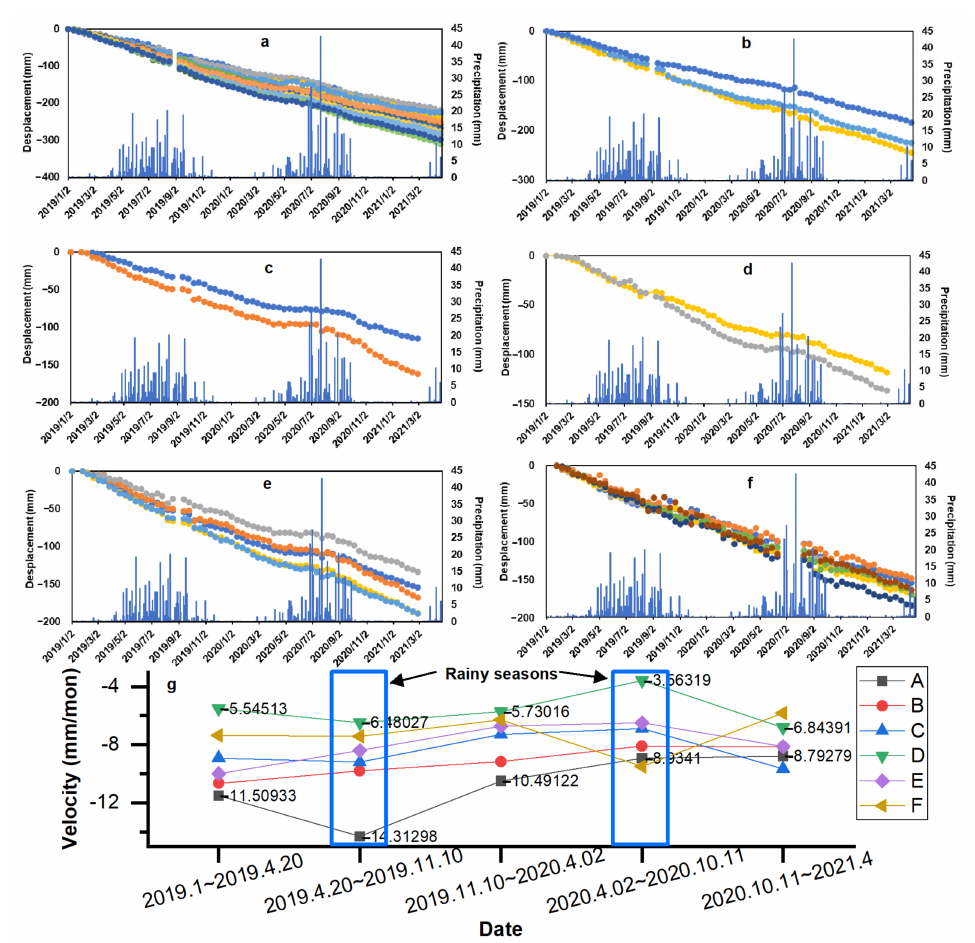
Figure 10. ( a – f ) Multi-series deformation of points corresponding to the areas shown in Figure 9g,h. ( g ) Velocity characteristics before and after the rainy season for the areas shown in Figure